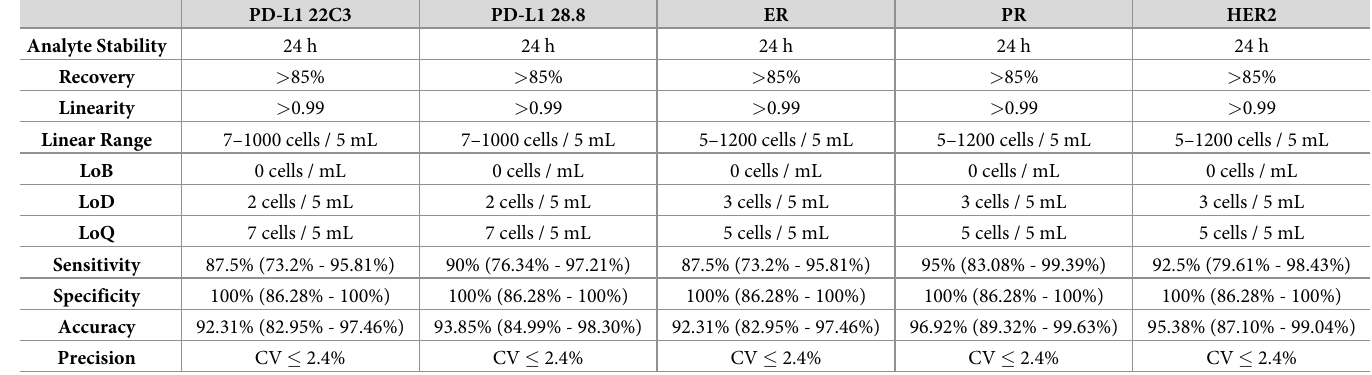
Table 1. Summary of analytical validation. The findings of Analytical Validation indicate that the Test provides reliable, accurate and reproducible results when samples are obtained, stored and processed under the recommended